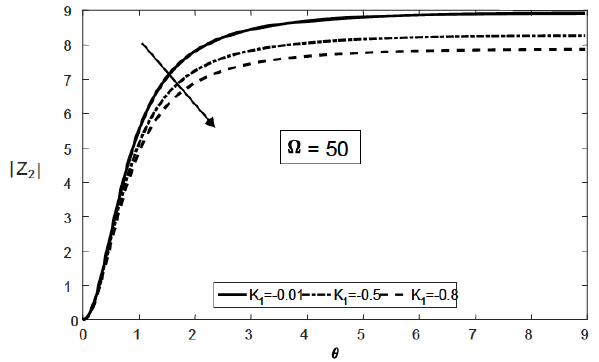
are in red, blue and green colors for Ω = 0, 50 and 100 re- spectively.